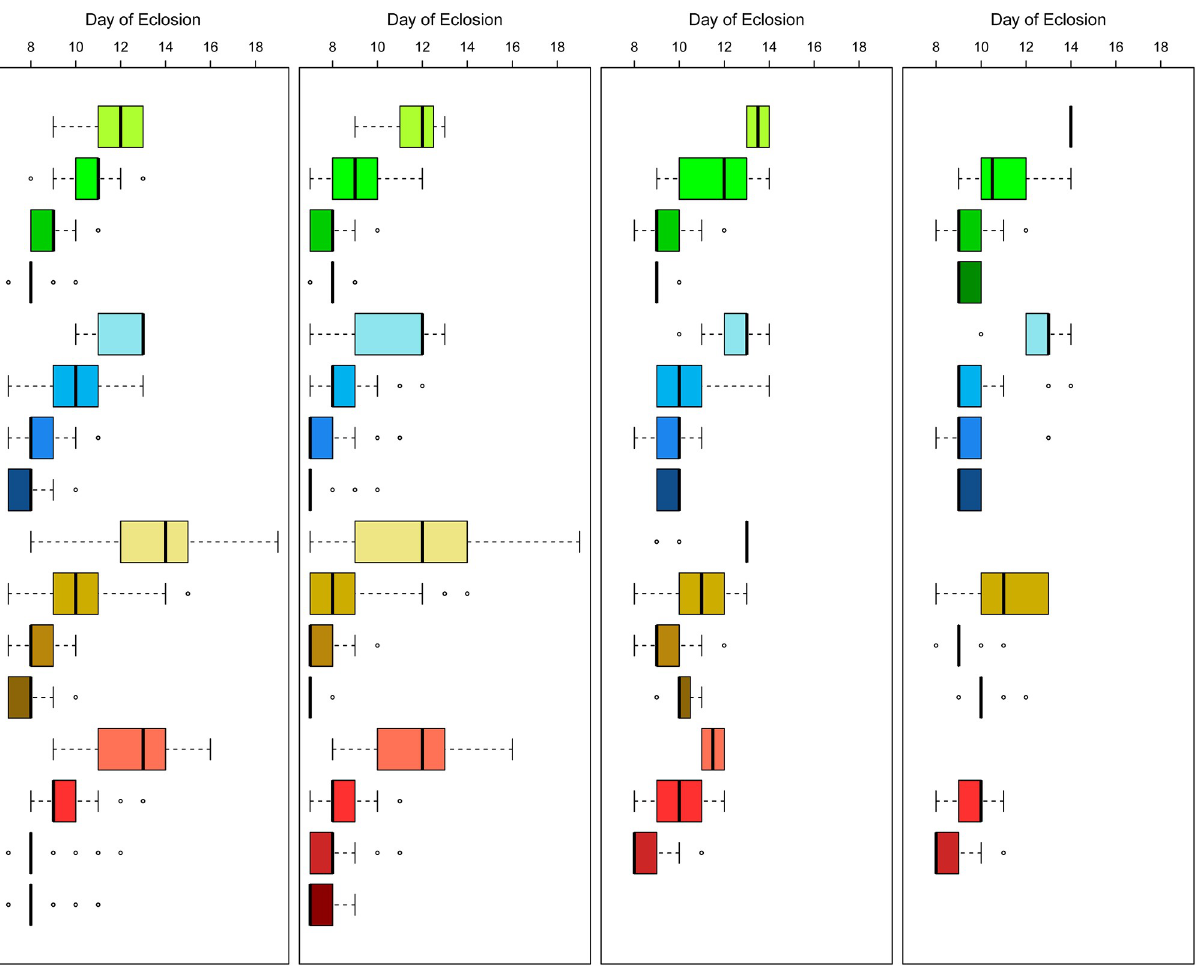
Fig 4. Day of eclosion. The panels are, left to right, Ae . aegypti females, males, An . gambiae females, males. The dark line indicates the median day of eclosion for each condition. The boxes contain the two central quartiles and the whiskers contain the outer quartiles unless outliers are present. These are indicated by points. Darker shades of color indicate increasing diet levels, 8, 16, 32 and 64 mg; CDC, green; Frontier, blue, Koi, brown and TetraMin, red.